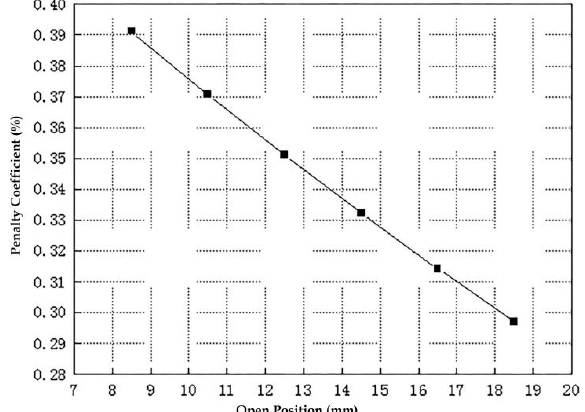
Figure 14. The distribution of the optimal penalty coefficient in the open location is shown in Figure 14. The larger the opening position is, the smaller the penalty coefficient is.